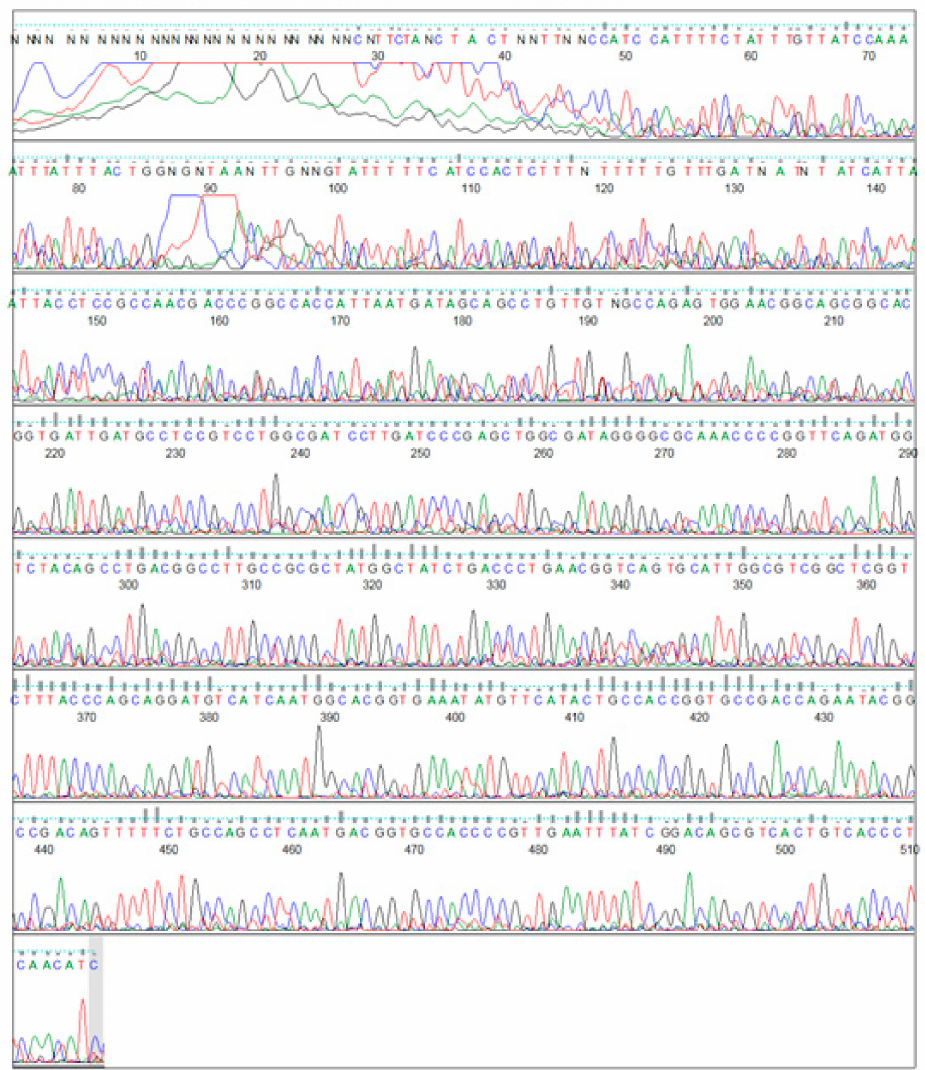
Figure 4. Gene sequencing of the glyoxalase I , a salt tolerance gene from Jojoba ( Jo-Glo1 ), by forward primer